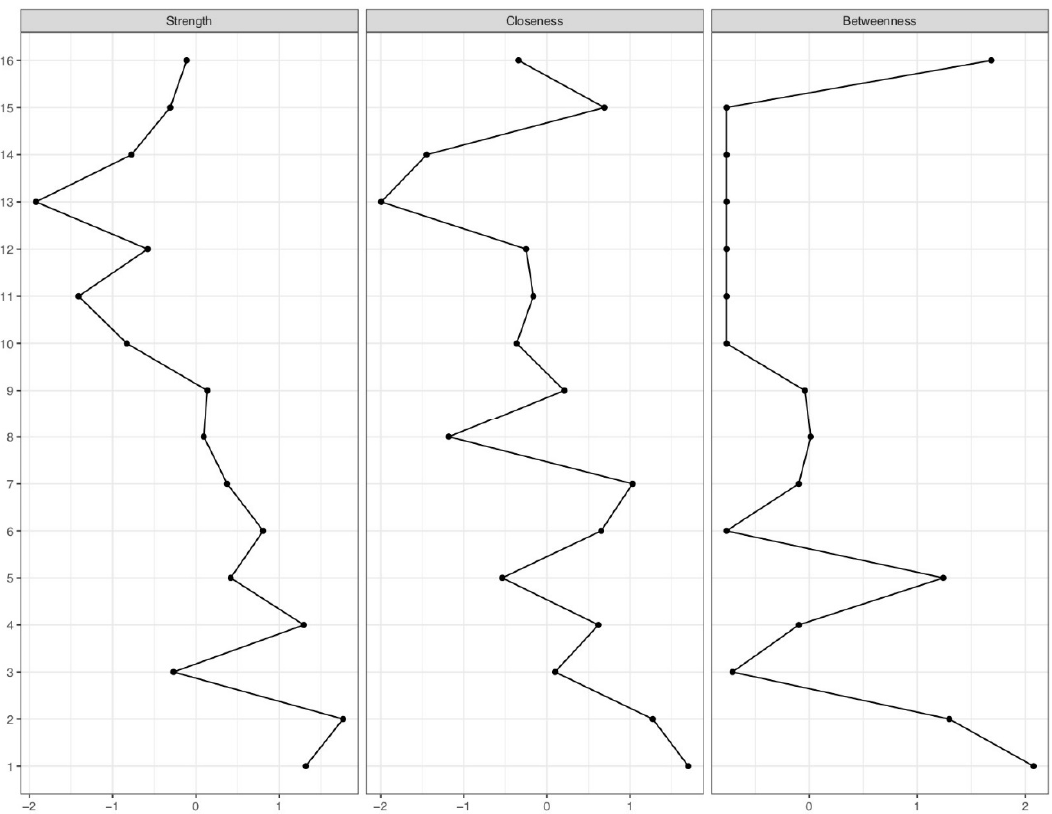
Figure 2. Display of centrality indices strength, closeness, and betweenness. The numbers on the y-axis represent the allocated nodes numbered sequentially. The x-axis represents z-values associated with the centrality indices. The higher the z-value, the higher the centrality index of the respective variable. For a node legend, see Figure 1. For a detailed explanation of the centrality indices, see Section 2.3 Data Analysis .